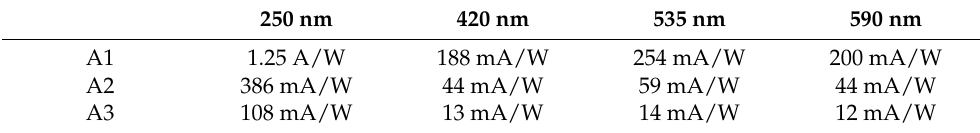
Table 6. Responsivity of Au/SRO/Si structures at different wavelengths.